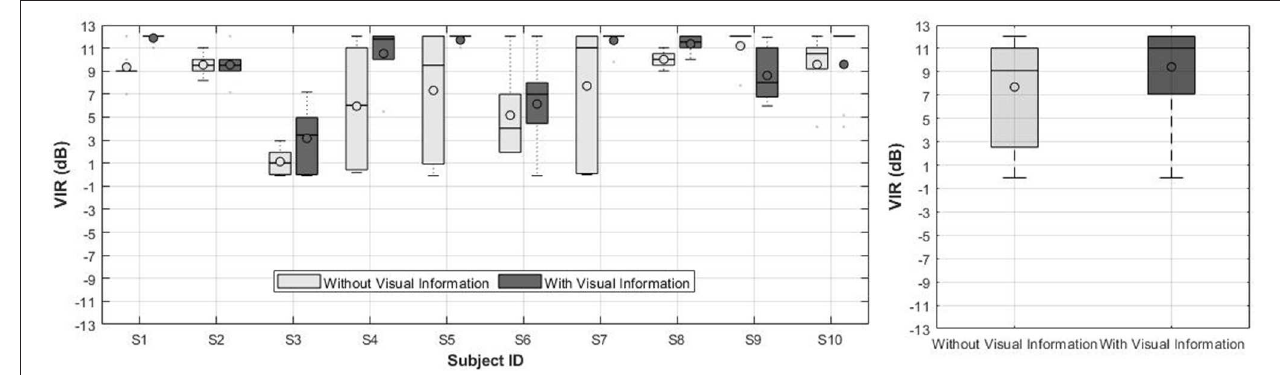
FIGURE 6 | (Left) VIR values from 10 CI users in Experiment 2. (Right) Mean VIR across subjects and music tracks for Experiment 2.